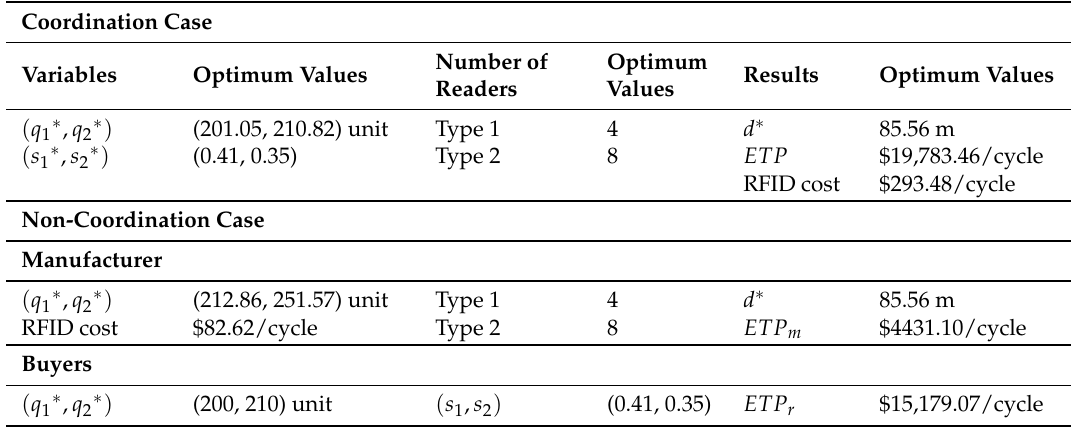
Table 4. Optimum results from the numerical analysis for Example